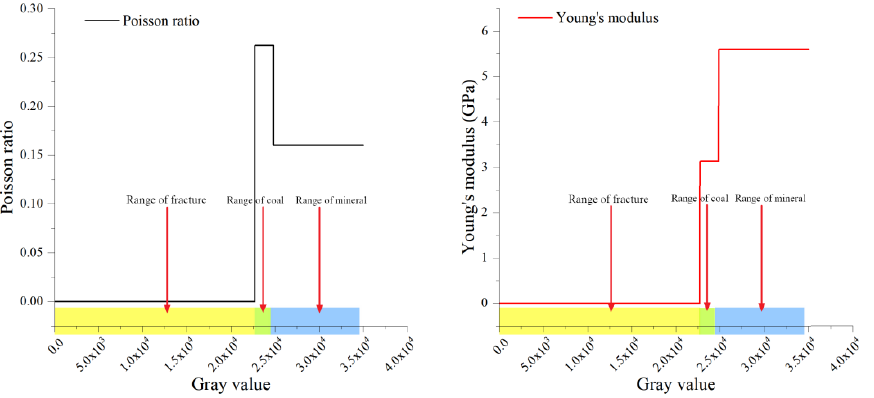
Figure 13. Setting the simulation parameters for different matrices.